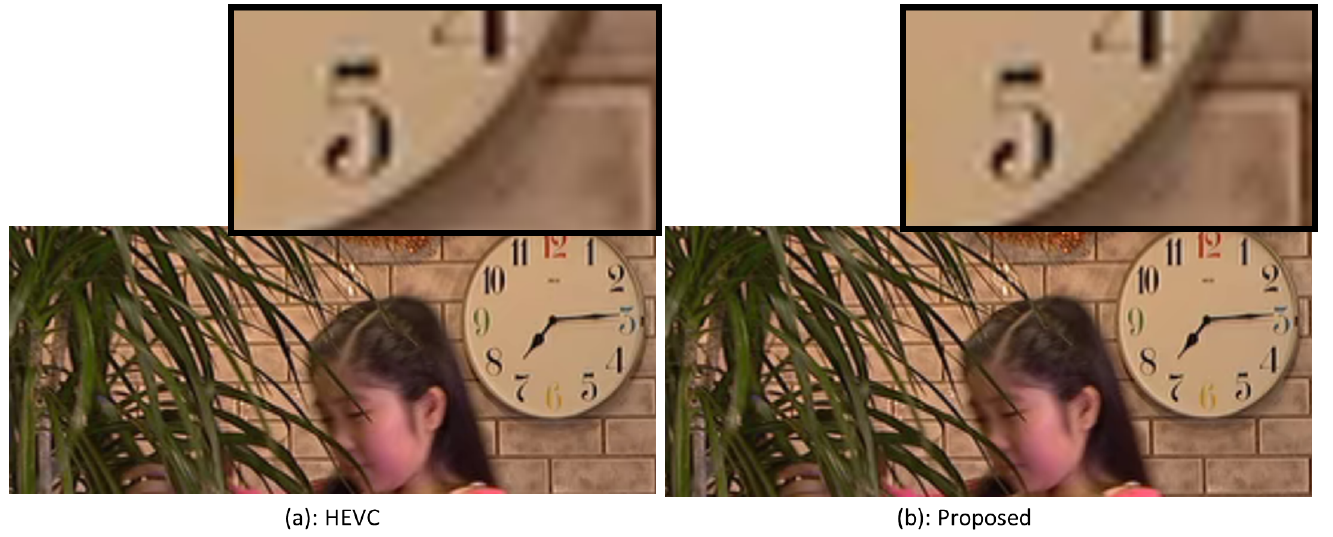
Figure 8. Application of proposed algorithm on PartyScene test video sequence of